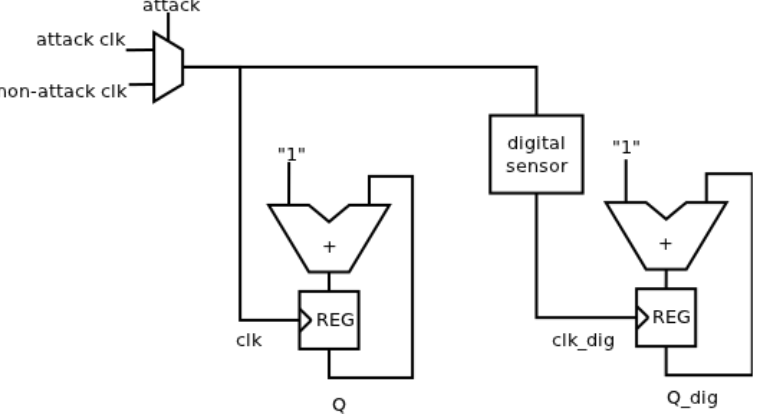
Figure 13. Scheme to block level of the verification environment corresponding to the proposed VLSI sensor.